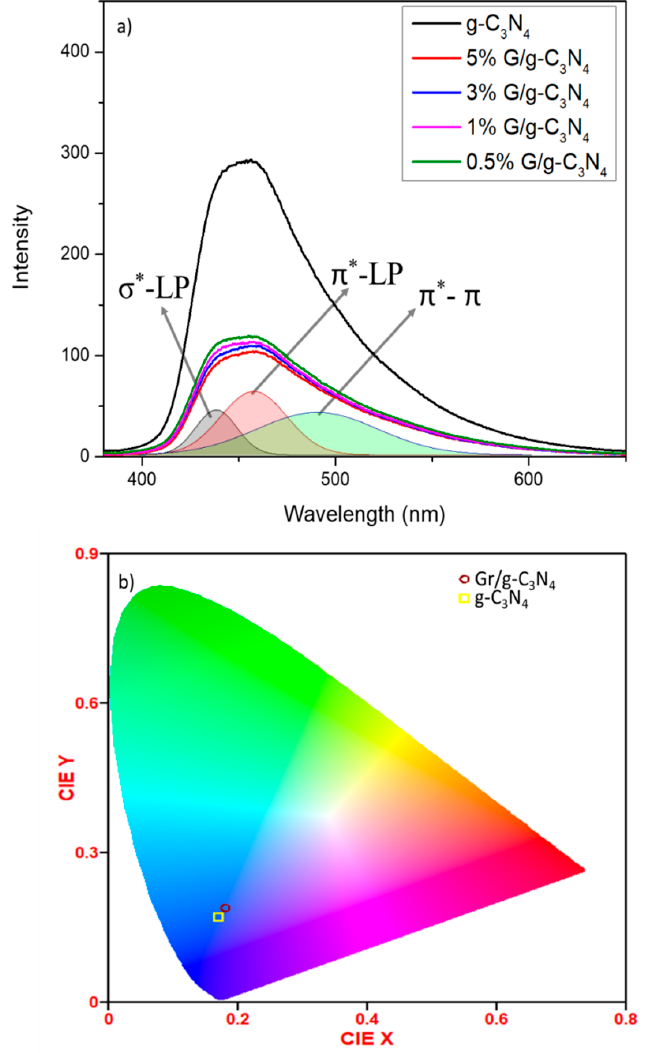
Figure 6. ( a ) The PL emission spectra of the prepared samples; ( b ) the (CIE) chromaticity diagram of the pure g-C 3 N 4 sample and the Gr/g-C 3 N 4